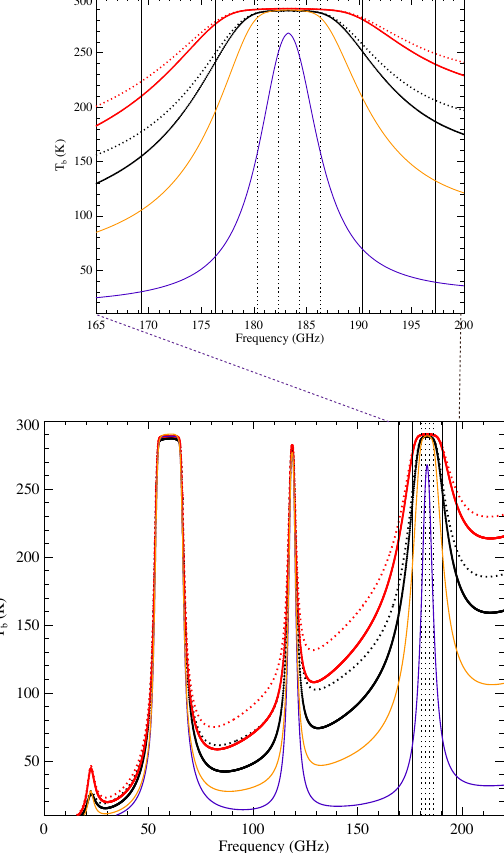
Fig. 2. Downwelling brightness temperatures at 150m altitude cal- culated using the 10th and 90th percentile of the 330 RS-92 ra- diosondes reaching 50 hPa (WVPs of 11 and 21mm, black and red lines respectively), for 0–220GHz (bottom panel) and 165– 200GHz (top panel). Cloudy-sky (LWP=100gm − 2 , cloud base at 1km) spectra are shown as dashed lines. Above-cloud spectra at 1370 m are also shown (WVPs of 1.9 and 9.8mm, purple and yel- low lines, respectively). Thin vertical lines indicate GVR frequen- cies, these are combined into four double-sideband values within the radiometer.